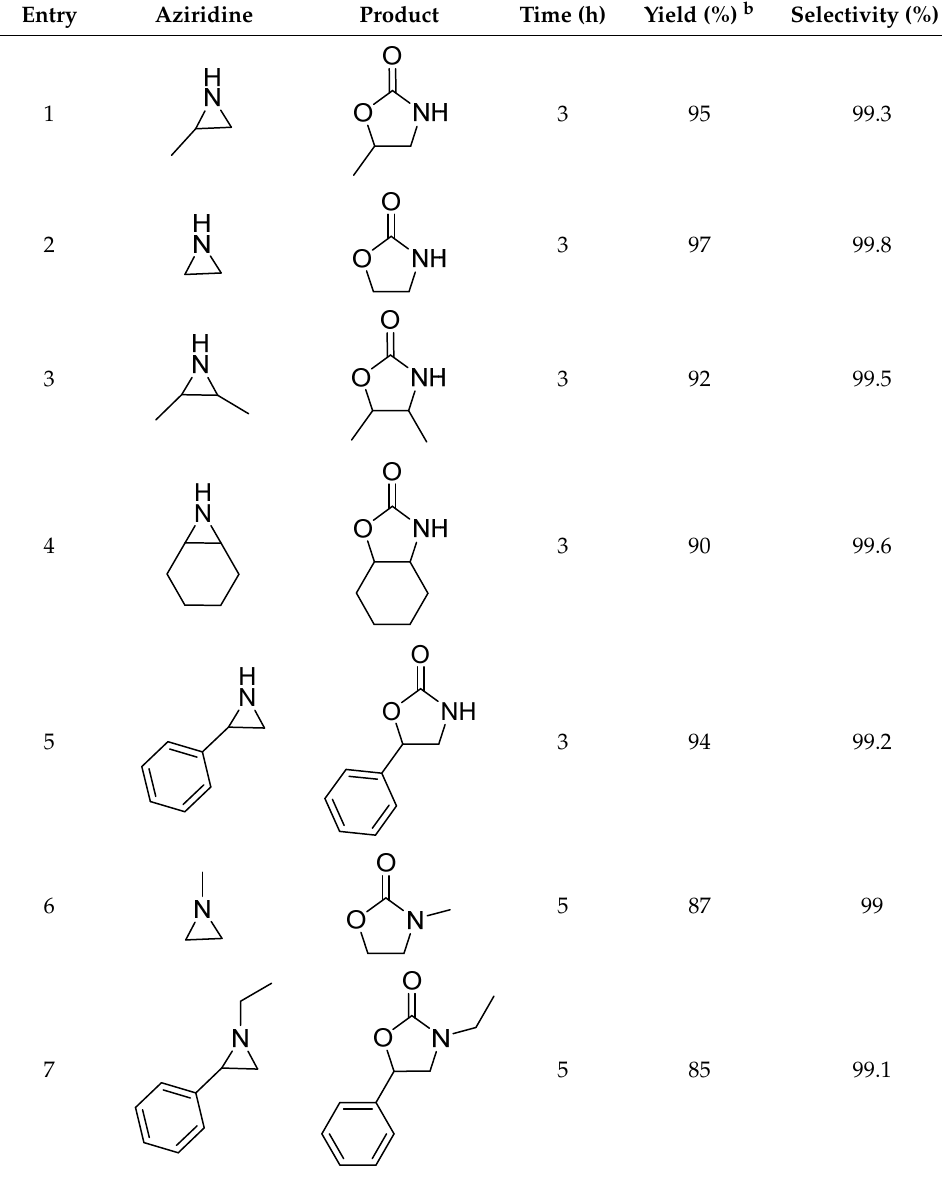
Table 1. Catalytic synthesis of 2-oxazolidinones a .